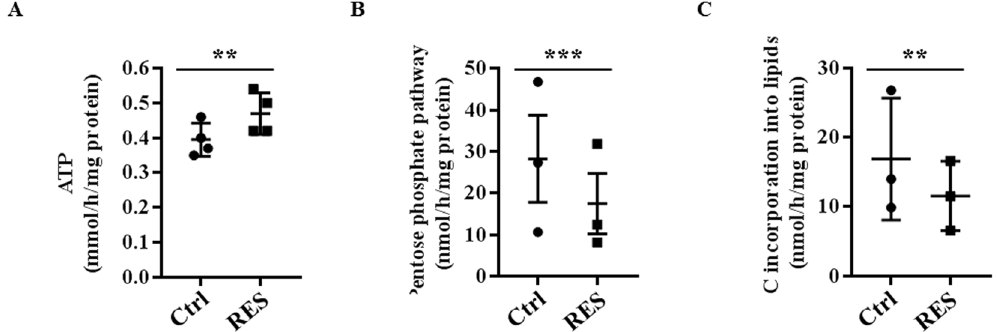
Figure 4. Resveratrol modifies glucose utilization in colon cancer cells. ( A ) Caco2 cells were treated with 10 µ M resveratrol (RES) for 48 hr and ATP production was estimated by using ATP Bioluminescence assay kit II. ( B ) After a 48 hour-treatment with 10 µ M, subconfluent Caco2 cells were isolated and 10 6 cells were incubated in Krebs-Ringer phosphate buffer supplemented with 5 mM [ 14 C 1 ]-glucose (isotopic dilution 1/1000) or [ 14 C 6 ]- glucose (isotopic dilution 1/100). 14 CO 2 was recovered and pentose phosphate pathway (PPP) activity was calculated as described in the Material and Methods section. ( C ) After treatment with resveratrol, cells were isolated and incubated in Krebs-Ringer phosphate buffer supplemented with 5 mM [U 14 C]-glucose (isotopic dilution 1/1000). The incorporation of carbons from glucose was measured in total lipids according to Bligh and Dyer 57 as described in the Material and Methods section. The means ± SEM are shown for at least three independent experiments performed in triplicate ( ** p < 0.01, *** p < 0.001 vs